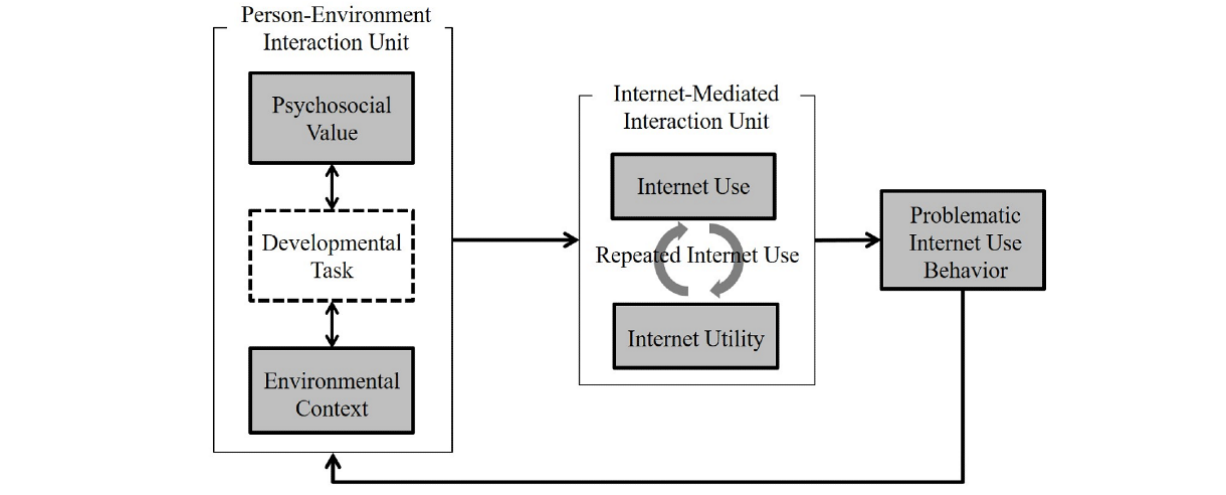
Figure 1. The Cyclic Value-Context Reinforcement Model of problematic internet use